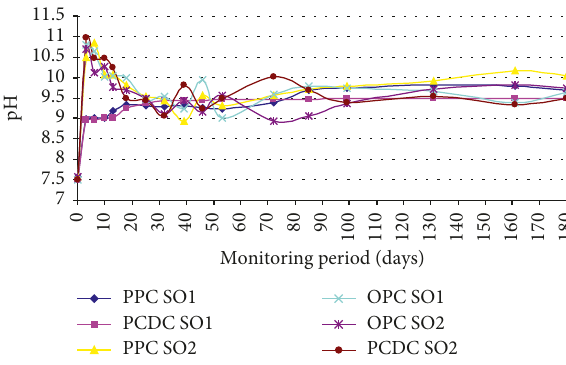
Figure 13: pH measurements in simulated sulphate solutions.